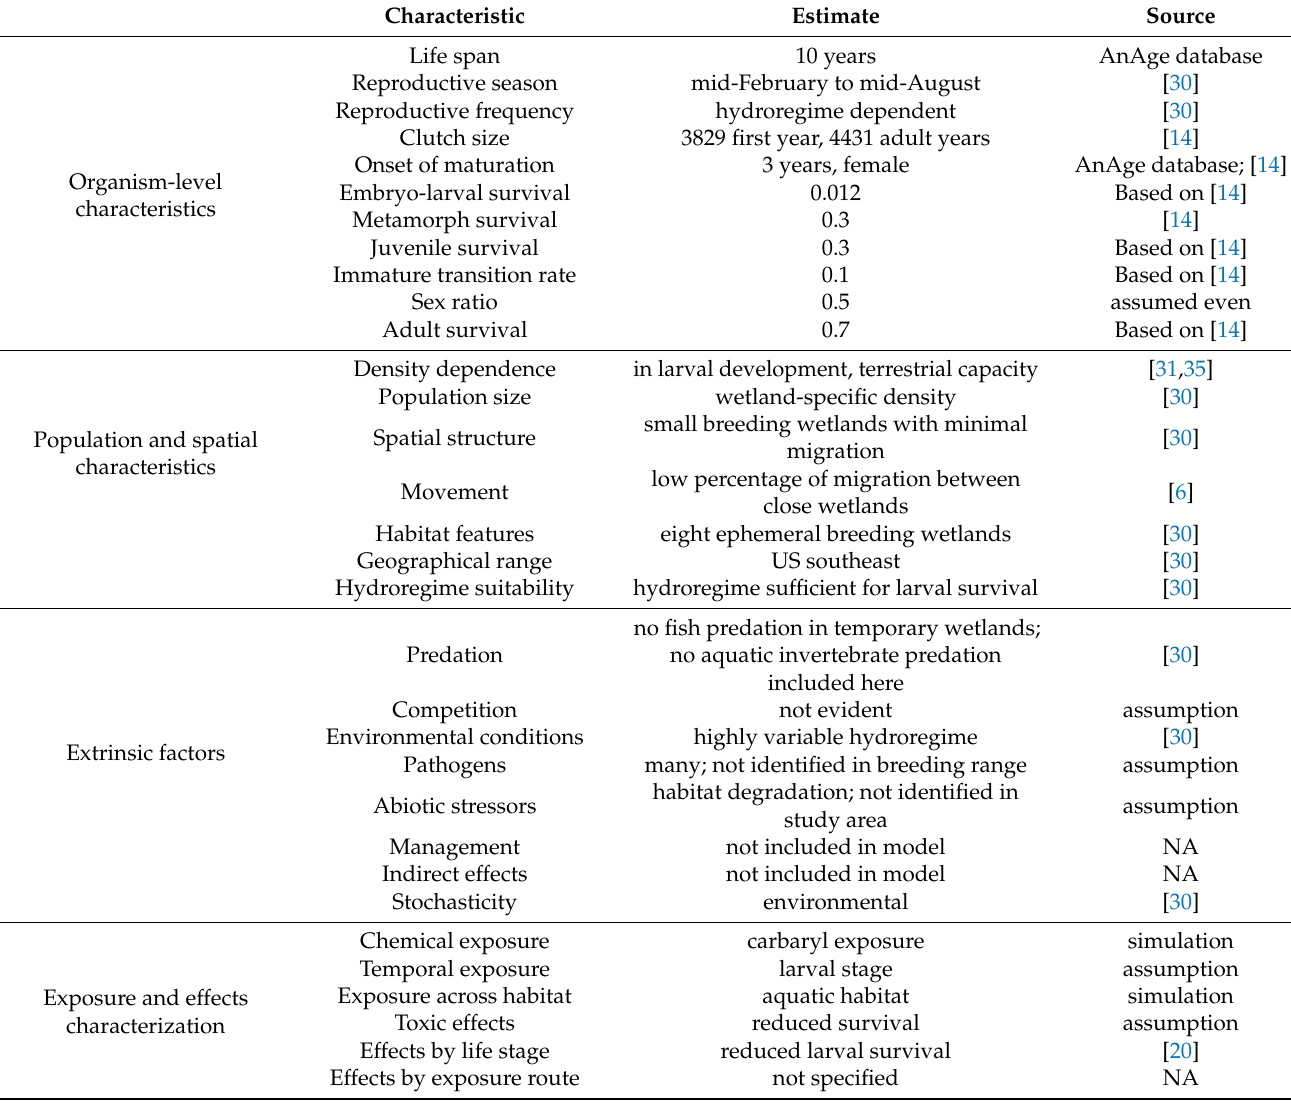
Table 1. Data compilation for southern toad